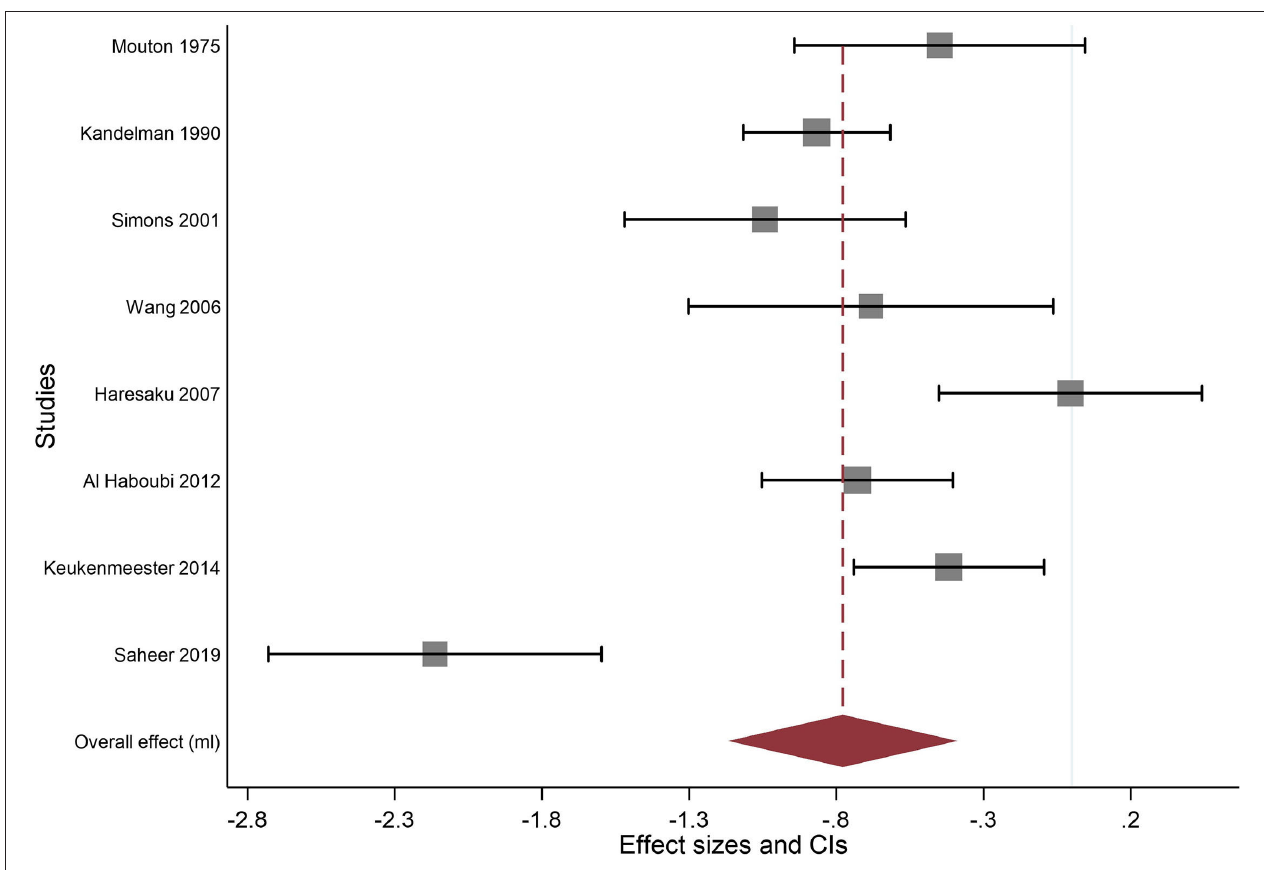
FIGURE 3 | Original weights (squares) displayed. Largest to smallest ratio: